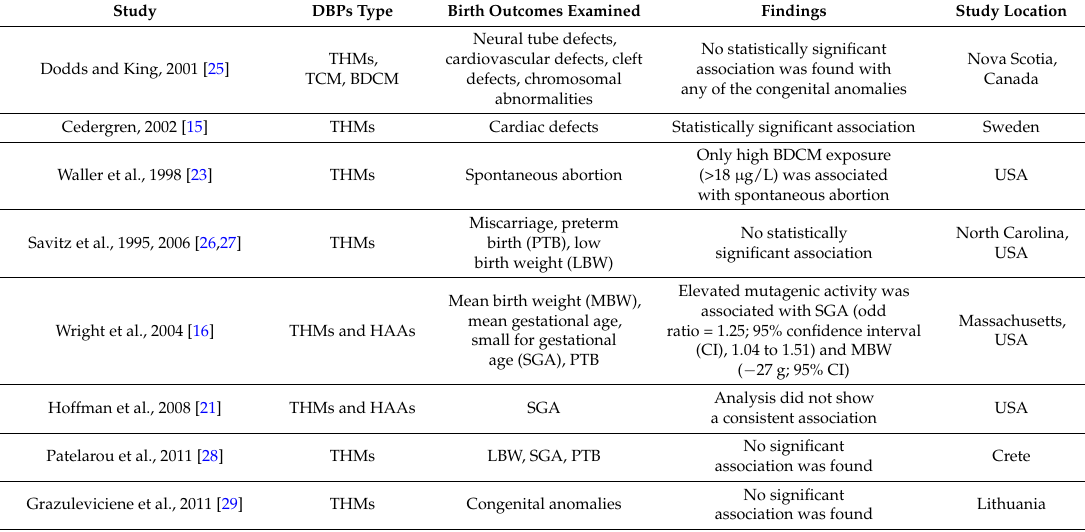
Table 1. Summary of key birth cohort studies on THMs and HAAs with inconclusive